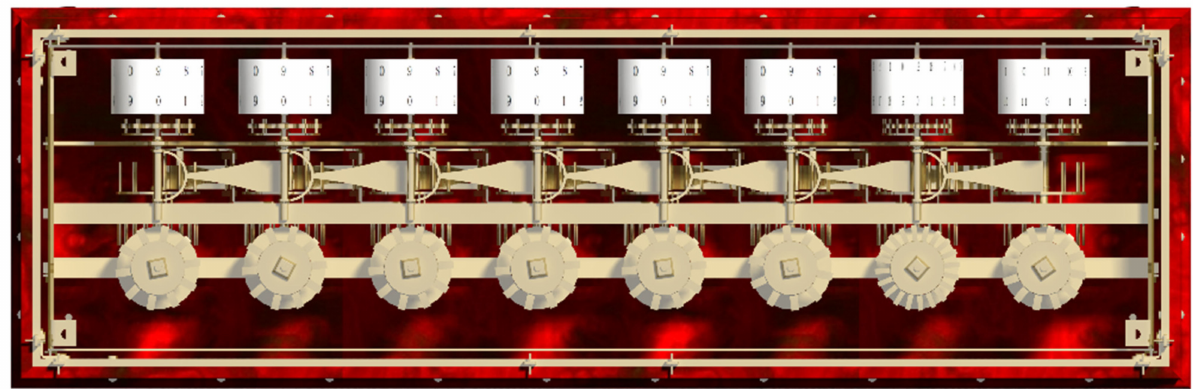
Figure 26. Top view of the Pascaline without its